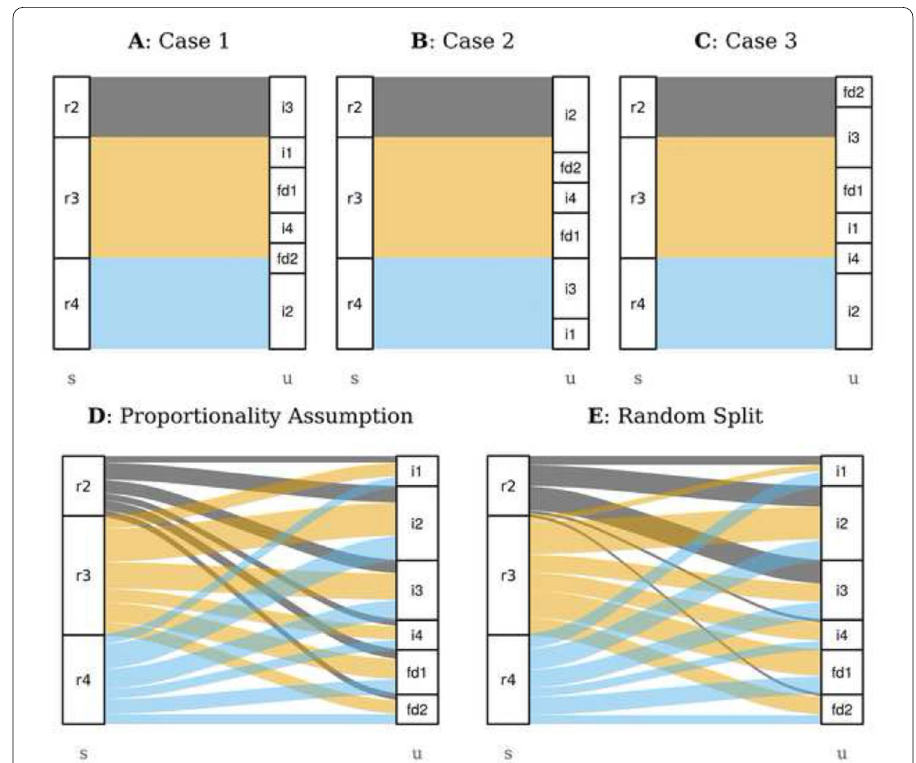
Fig. 2 Sankey diagrams illustrating different possible ways to allocate s to u . A – C Three possible outcomes of our algorithm. D allocation based on proportional import shares. E An example of an intermediate case which is not covered by our